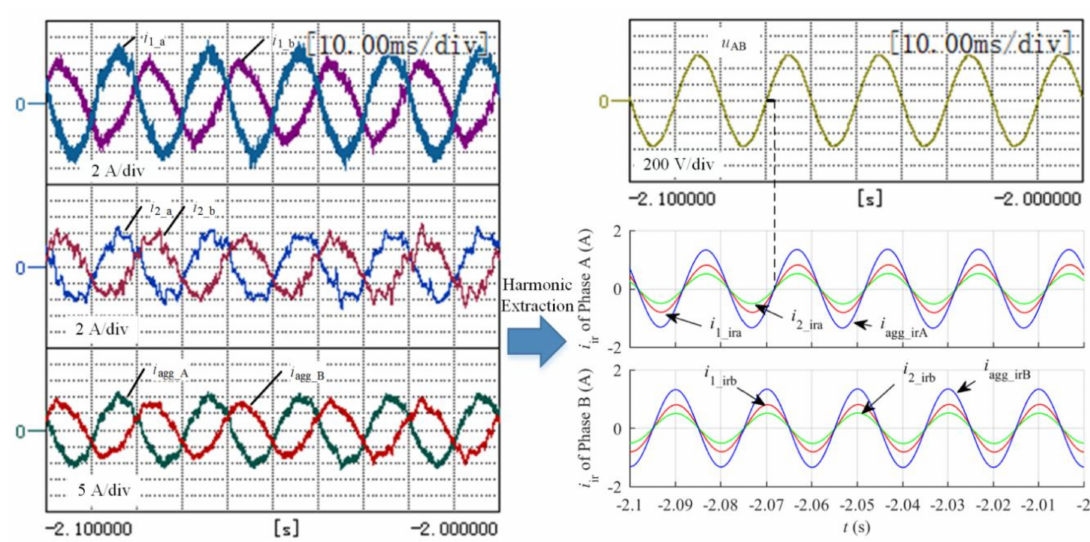
Figure 16. Actual negative sequence 50 Hz